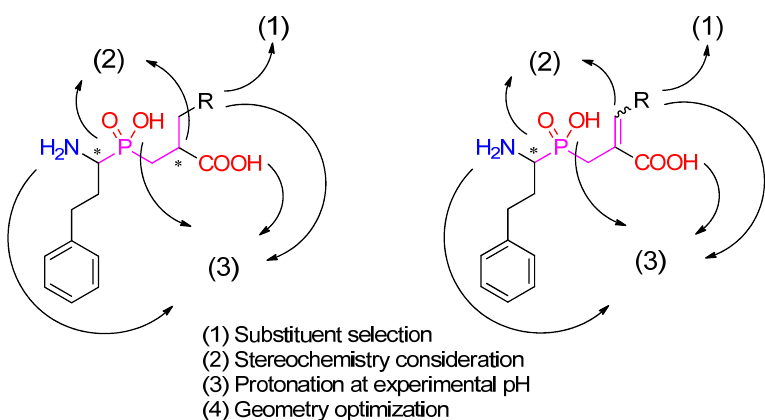
Figure 1. A general procedure for phosphinic ligand preparation. Following the R substituent selection, four possible stereoisomers (either R/S, R/S or R/S, E/Z combinations) were considered in the calculations.